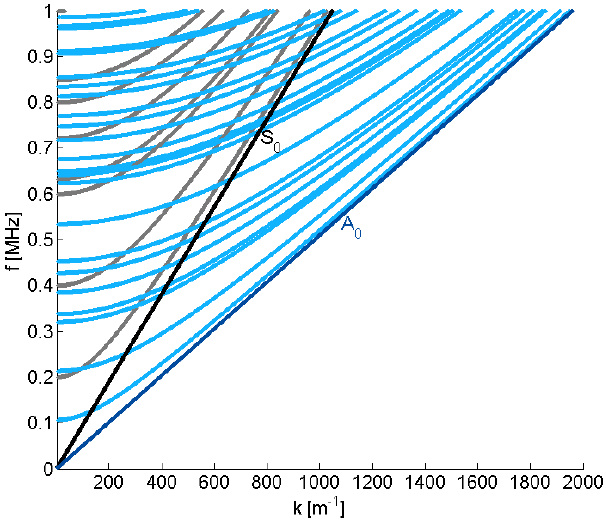
Figure 2. Modes S n and A n of a rectangular waveguide, with section 15 × 5 [mm], in the frequency range [0, 1] MHz. Notice that in this graph the wave number is defined as k = 2 π / λ [m − 1 ].